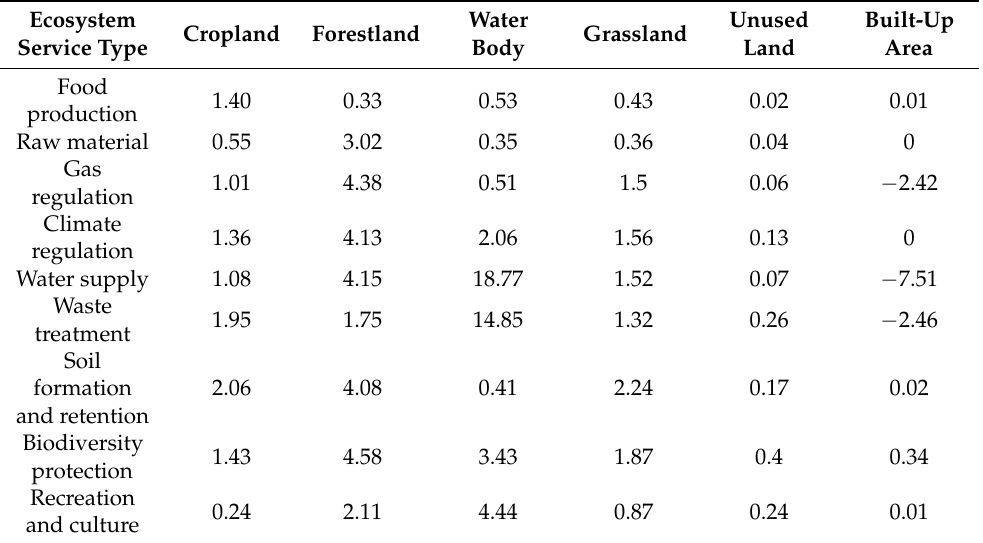
Table 2. Locally adapted value coefficients of ecosystem services per unit area for